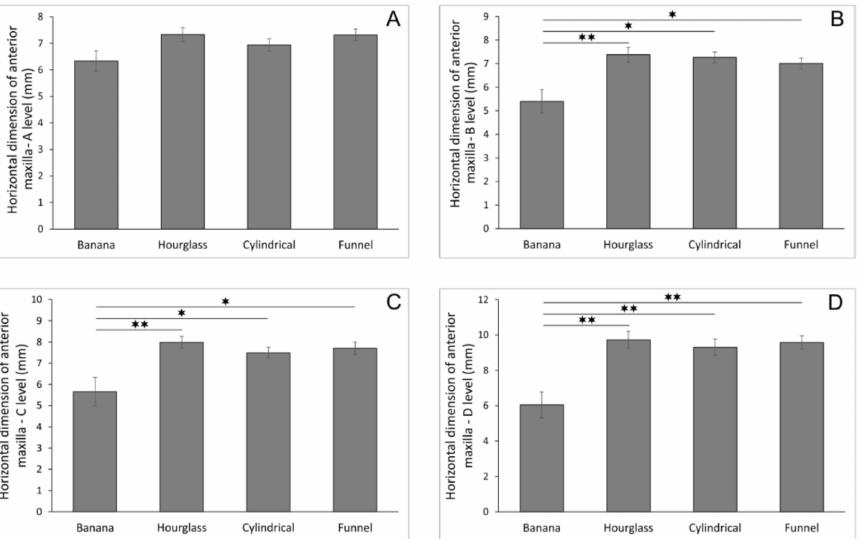
Figure 3. The horizontal dimension of the anterior maxilla at different levels according to the nasopalatine canal shape in sagittal cross-section (in mm). ( A ) horizontal dimension of anterior maxilla—A level; ( B ) horizontal dimension of anterior maxilla—B level; ( C ) horizontal dimension of anterior maxilla—C level; ( D ) horizontal dimension of anterior maxilla—D level. Values are expressed as the mean ± SEM. * Denotes a significant difference of p < 0.05, ** denotes a significant difference of p <